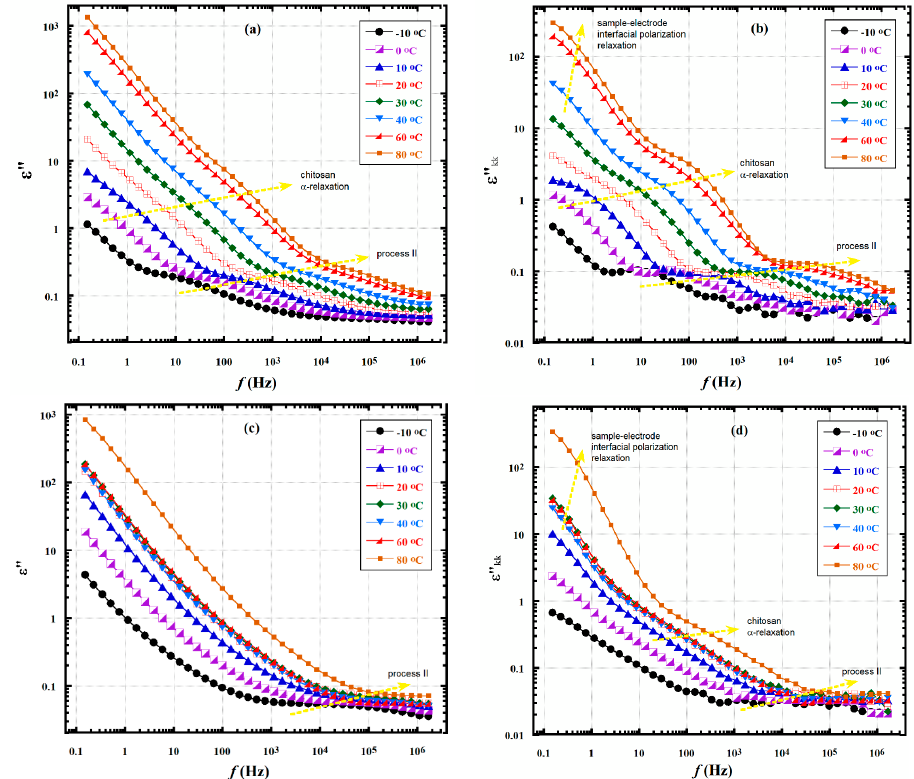
Figure 8. ε ′′ vs. f spectra for control chitosan film ( a , b ) and the electrospun chitosan/PVA/AgNPs composite blend ( c , d ) before and after the KK transformation, in the temperature range of the chitosan T g . Dashed arrows indicate the progress of different relaxations with increased temperature.